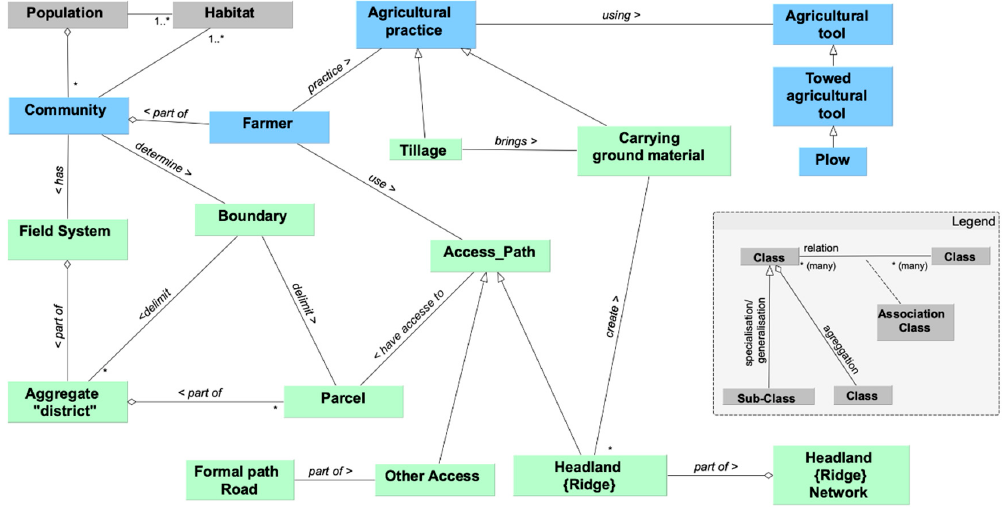
Figure 8. UML schema of a circulation system in the Beauce region.